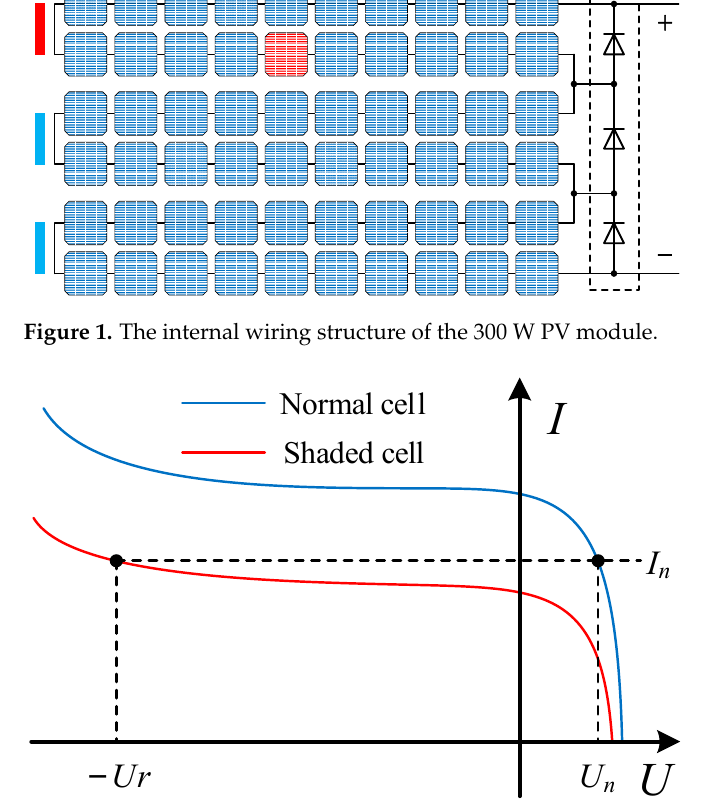
Figure 2. Current–voltage curves of normal and shaded cells in the same substring. The on–off state of the bypass diode is analyzed. Assuming that there is one